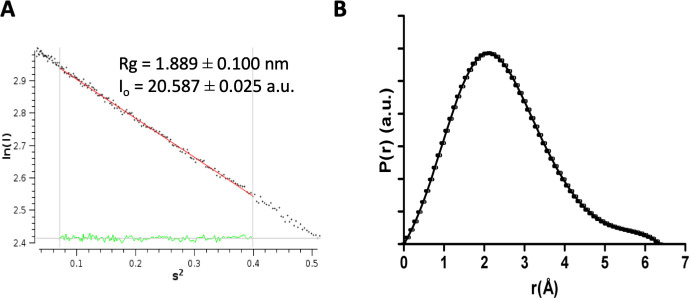
SAXS processing analysis.(A) The linear region of the Guinier plot measured from the raw SAXS data for DolP. Values for Rg and I(0) are shown calculated using AutoRG in program Primus. (B) Pair-wise distance distribution P(r), calculated from the scattering curve of DolP, calculated using gnom arbitrary units (a.u.).